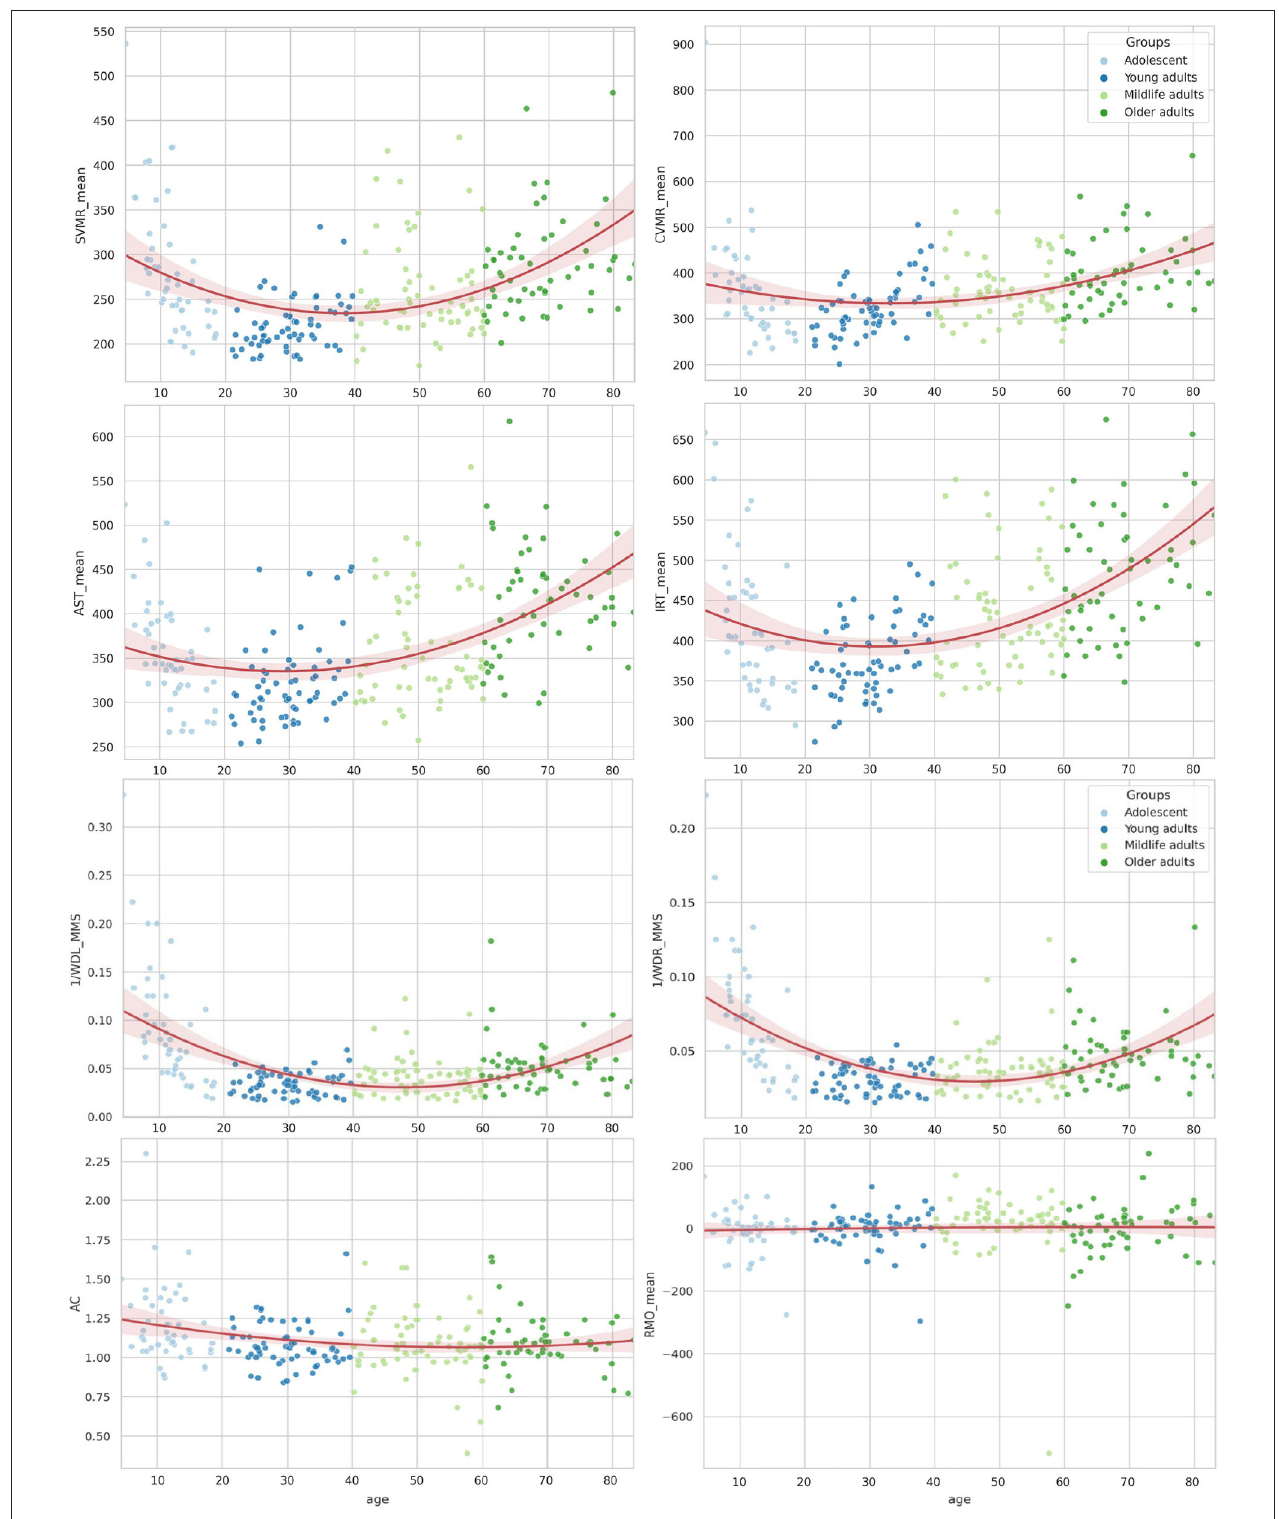
FIGURE 3 | Distribution of reaction time attributes by age for psychophysiological tests and wrist dynamometry.